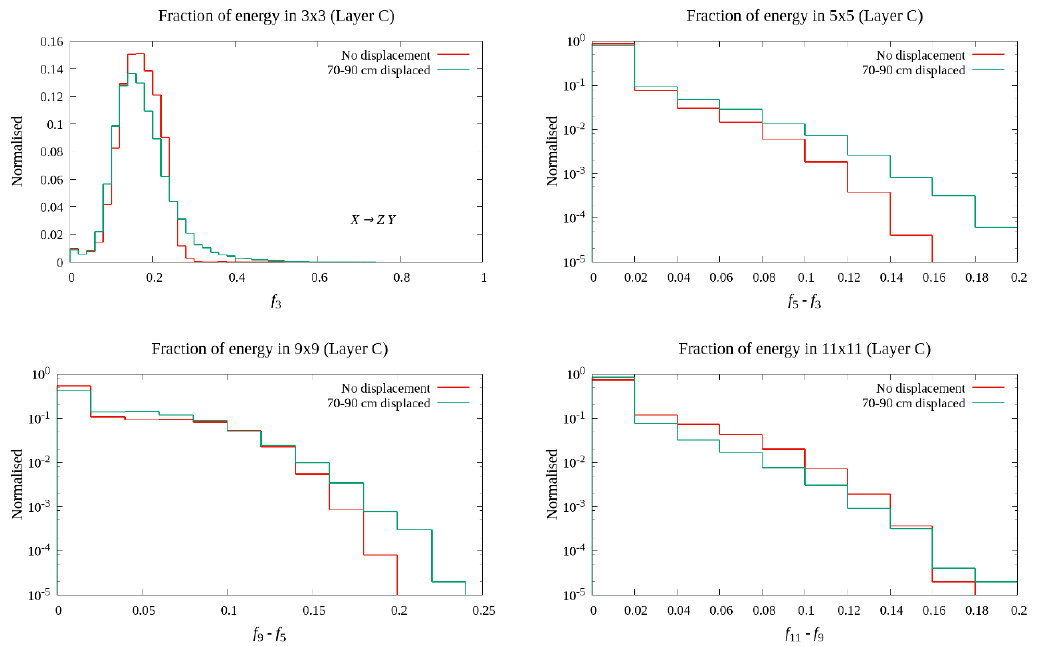
Figure 17. Normalised distributions of energy deposition fraction ( f i ) with varying sizes of blocks ( i (cid:2) i ) for the non-displaced and 70{90 cm displaced Z boson in layer C. Open